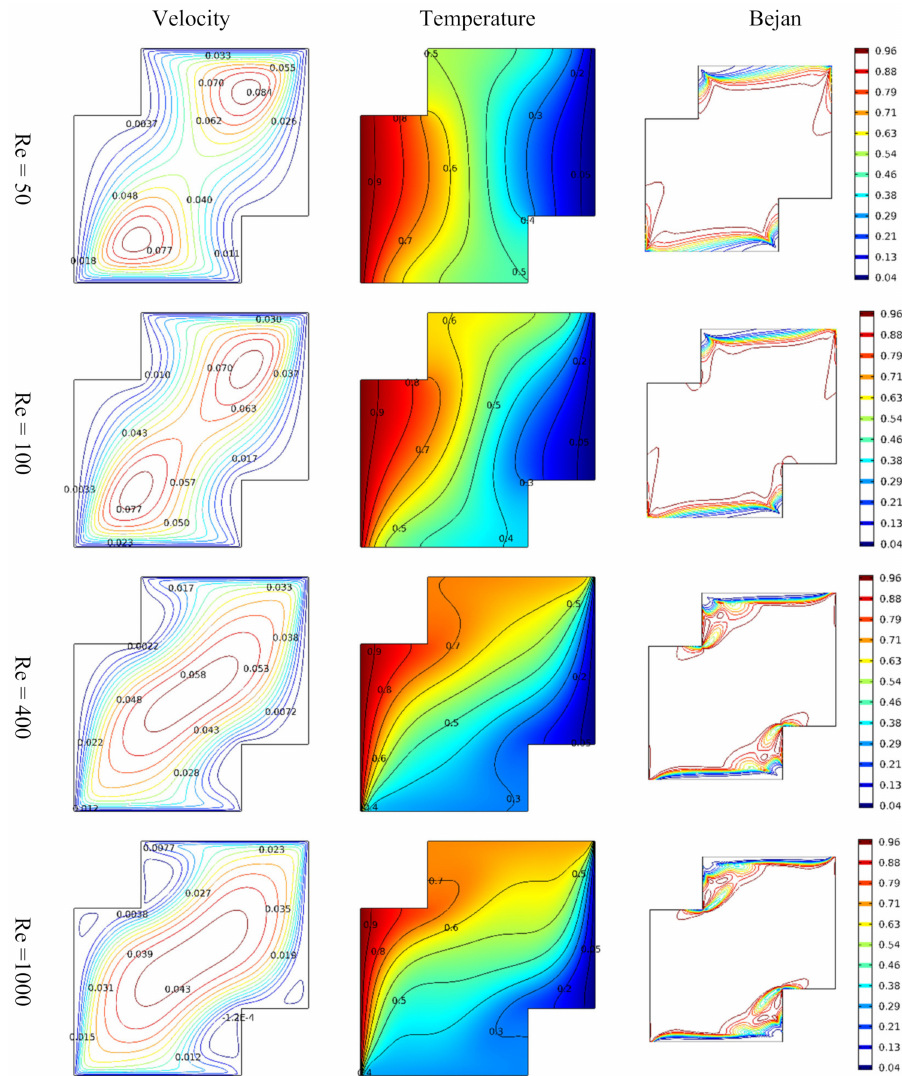
Figure 3. Variations in the velocity, temperature distribution, and entropy generation at different levels of Reynold